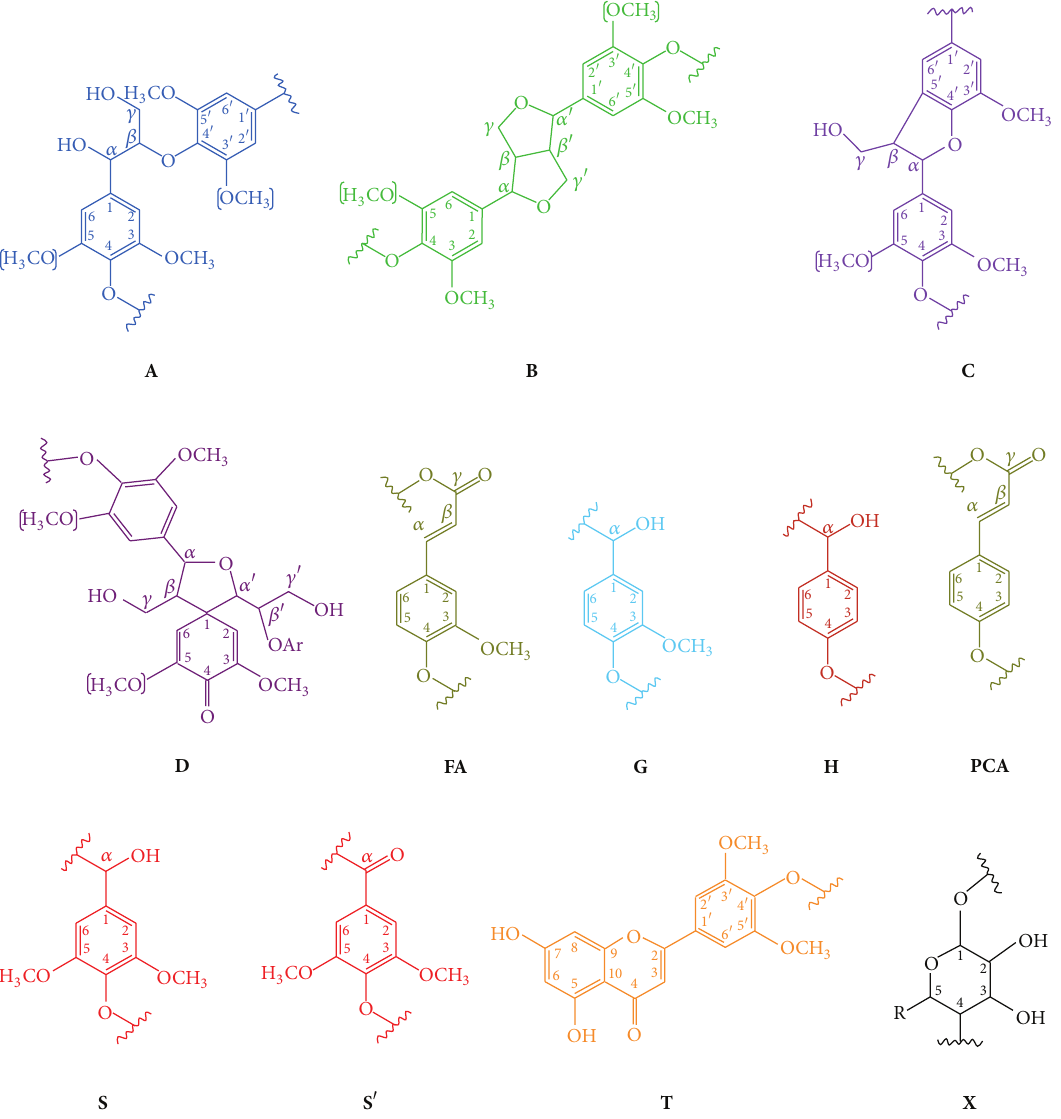
Figure 3: Main lignin and carbohydrate structures identified in the lignin-rich residues from wheat straw and olive tree pruning WIS fractions: A , 𝛽 - O -4 󸀠 ; B , resinols with 𝛽 - 𝛽 󸀠 , 𝛼 - O - 𝛾 󸀠 , and 𝛾 - O - 𝛼 󸀠 linkages; C , phenylcoumarans with 𝛼 - O -4 󸀠 and 𝛽 -5 󸀠 linkages; D , spirodienones with 𝛽 -1 󸀠 , 𝛼 - O -4 󸀠 linkages; FA , ferulic acid; G , guaiacyl unit; H , p -hydroxyphenyl unit; PCA , p -coumaric acid; S , syringyl unit; S 󸀠 , oxidized syringyl units with a C 𝛼 ketone; T , tricin end unit; X , xylopyranose (R,